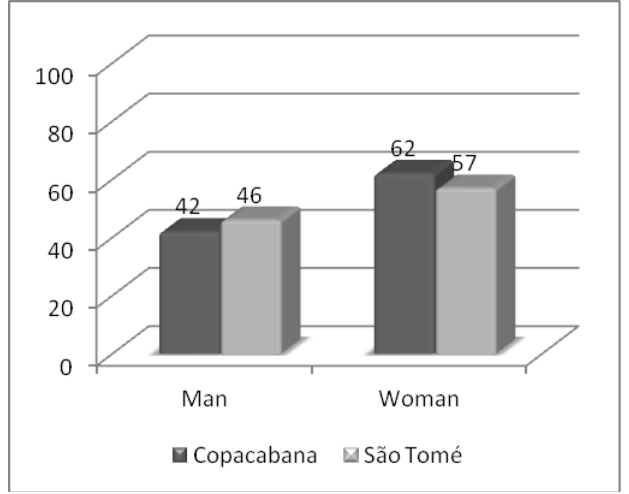
Figure 11. Actuation of sex for the application of number mark within the NP, in R.Ws, in Copacabana and São Tomé (all education